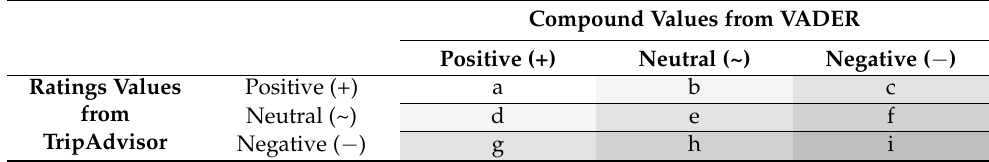
Table 2. Scheme of the 3 × 3 confusion matrix used in this study. Compound Values from VADER Positive (+) Neutral (~) Negative ( − ) Ratings Values Positive (+) a b c from Neutral (~) d e f TripAdvisor Negative ( − ) g h